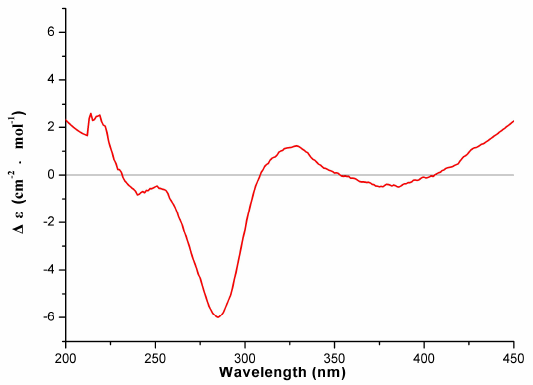
Figure 2. CD spectrum of compound 1 (in MeOH).